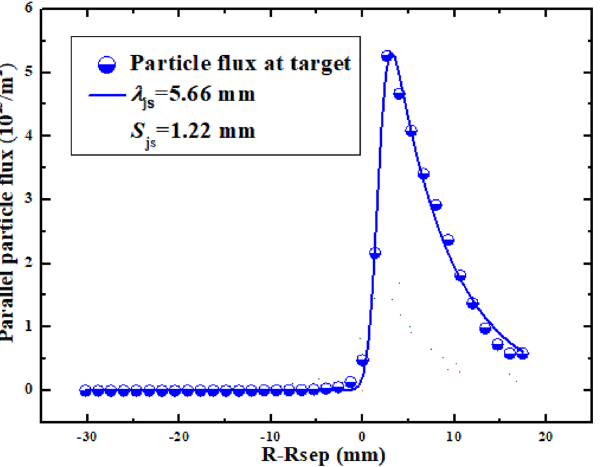
Figure 9. The parallel particle flux profile at the divertor target and the corresponding fit using Eq.